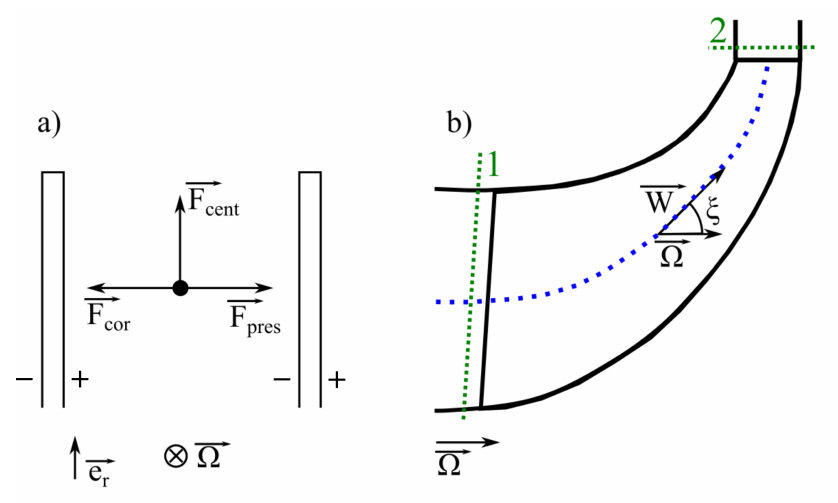
Figure A1. Scheme of forces in ( a ) centrifugal impeller and ( b )